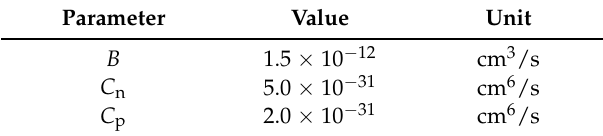
Table 1. Carrier recombination coefficients used in the calculation [40].